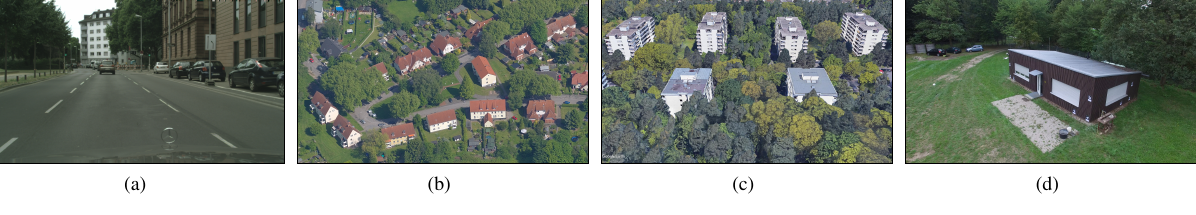
Figure 3. Example figures of the datasets used. (a) Cityscapes dataset showing an urban street scene with building fac¸ades. (b) ISPRS benchmark dataset comprising oblique aerial imagery of a suburban area. (c) Exemplary scene of the GoogleEarth dataset depicting different building kinds and dense vegetation. (d) Excerpt of our own dataset used to demonstrate the local image-based depth